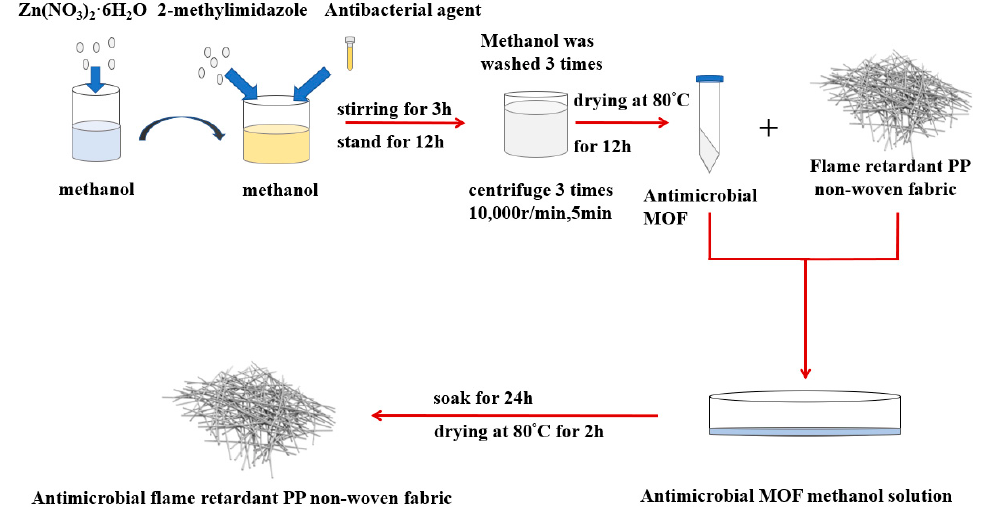
Figure 2. Flow chart of the preparation of polypropylene/zeolite imidazole framework-8 (PP/ZIF-8) melt-blown electrospun composite membranes.